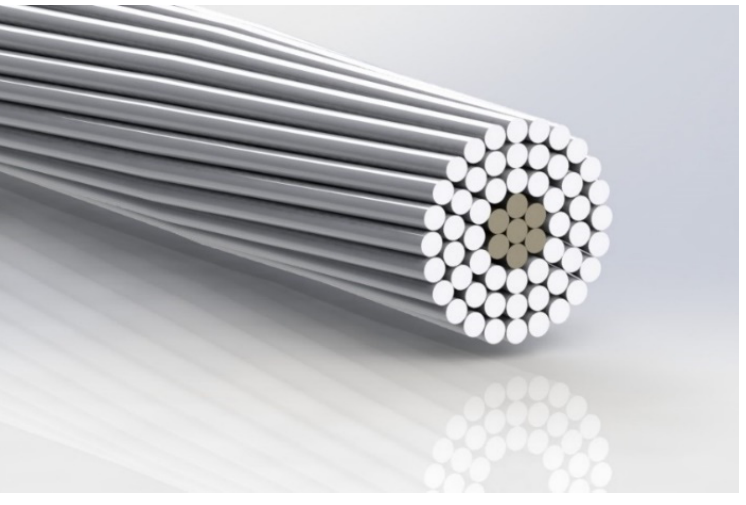
Figure 3. Cross section of the tested conductor. Table 3. Parameters of the tested ACSR conductor 550-AL1/71-ST1A.